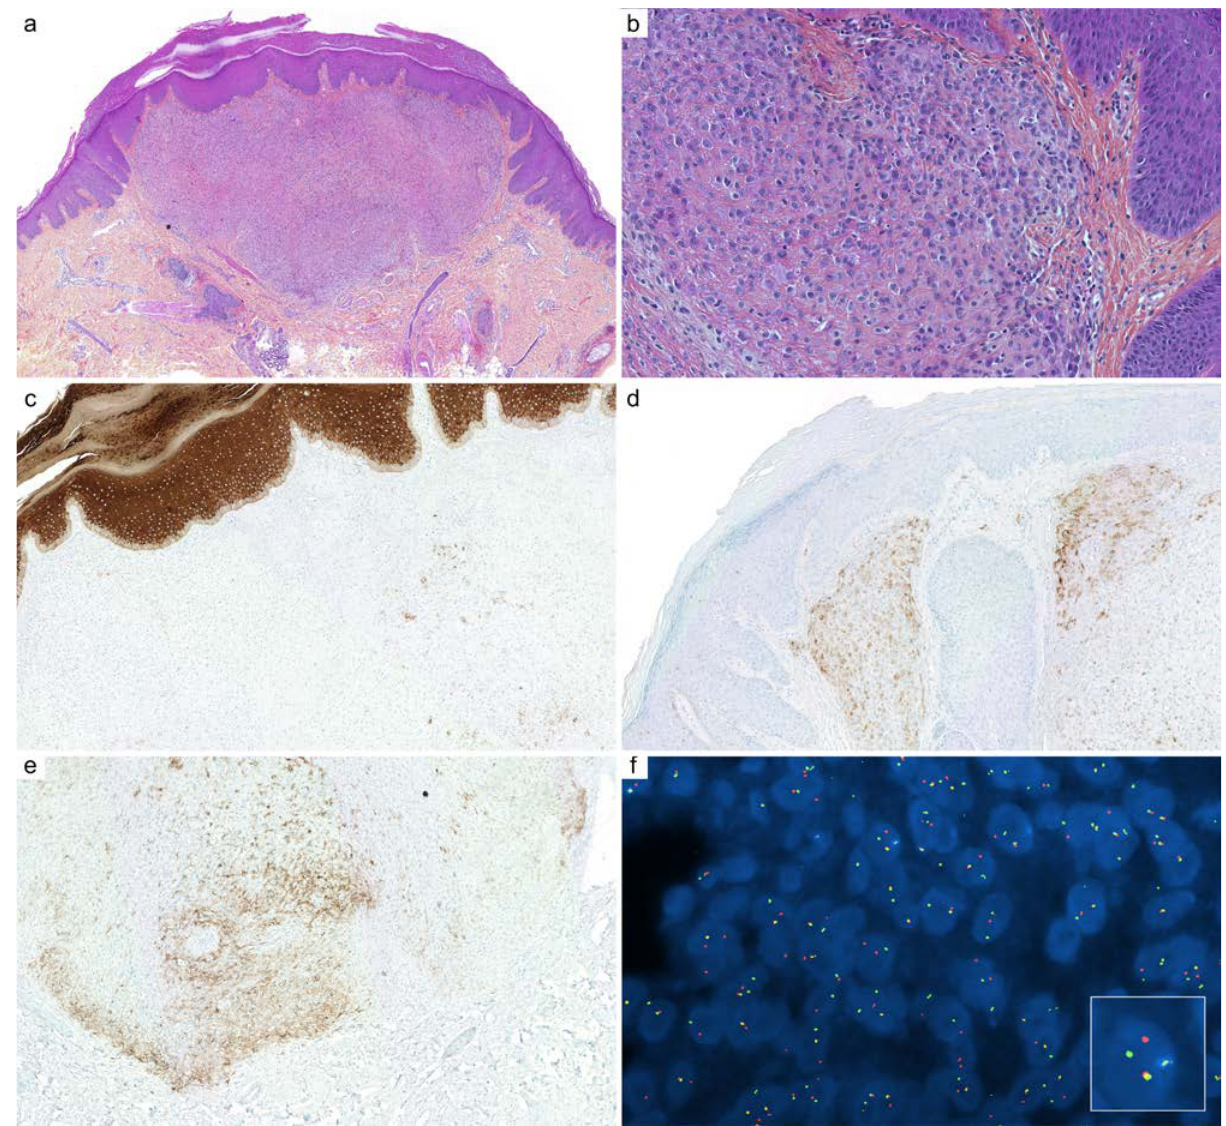
Figure 5. Cutaneous syncytial myoepithelioma: ( a ) this variant of myoepithelioma occurs predom- inantly in the superficial dermis (×25); ( b ) epithelioid and plasmacytoid cells are arranged in sheets with little or no intervening stroma (×200); ( c ) AE1/AE3 immunohistochemistry is most often nega- tive or stains only scattered isolated cells (×100); ( d ) PS100 (×100) and ( e ) EMA immunohistochem- istry stains various populations of cells (×100); ( f ) fluorescence in situ hybridization (FISH, break- apart) demonstrates clonal rearrangement of EWSR1 gene (x1000).